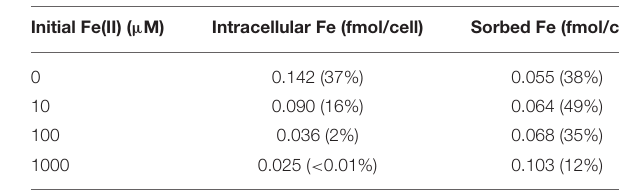
TABLE 2 | Intracellular and sorbed Fe concentrations when suspensions of Synechococcus PCC 7002 were incubated in light with different initial Fe(II)